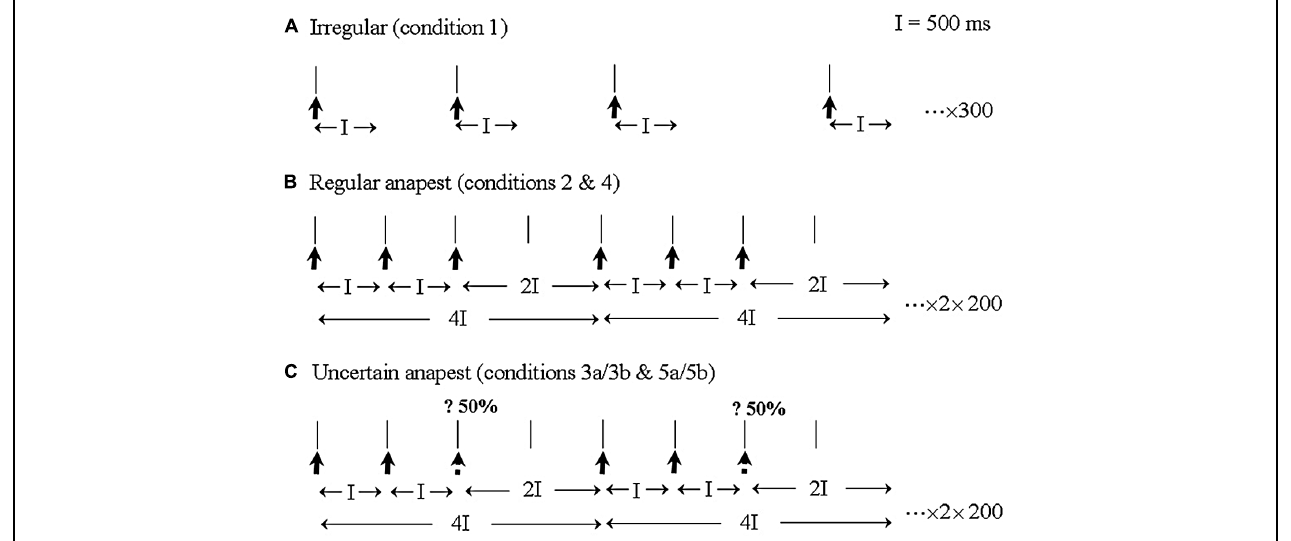
FIGURE 2 | An illustration of the three main stimulus categories and EEG recording epochs. (A) The irregular rhythm (condition 1) consisted of a sequence of clicks with random inter-click intervals between 1000 and 2000 ms. EEG was sampled continuously with an averaging epoch of 500 ms. (B) The regular anapest [condition 2 (passive) and 4 (active)] consisted of three clicks and a gap with inter-onset intervals of 500, 500 and 1000 ms, which metrically corresponds to a bar of “Three blind mice.” EEG was epoched for averaging over the whole duration of the anapest rhythm, including for the last